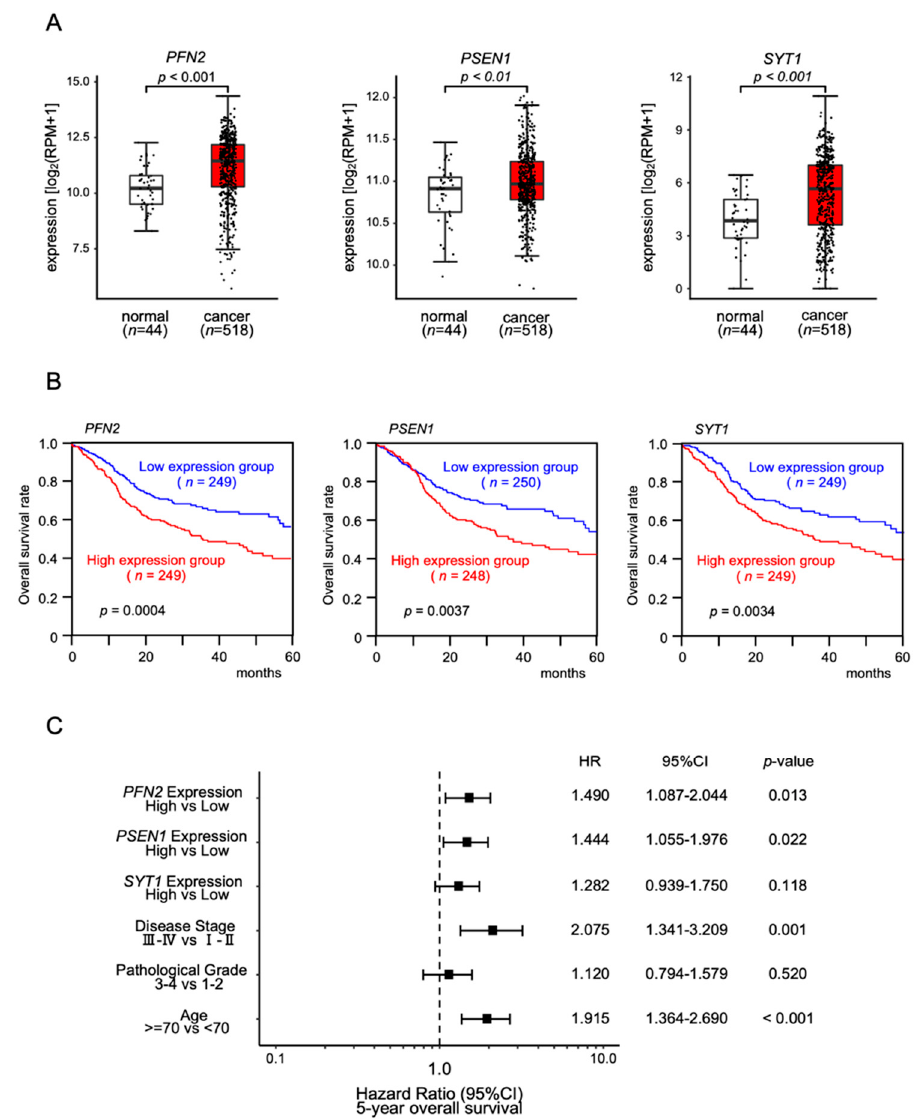
Figure 4. Clinical significance of PFN2 , PSEN1, and SYT1 in HNSCC clinical specimens determined by TCGA–HNSC analysis: ( A ) comparisons of expression levels of three genes between normal and cancer tissues in TCGA–HNSC; ( B ) Kaplan–Meier curves of the 5 year overall survival frequencies according to the expression of each gene; ( C ) forest plot showing the multivariate analysis results for the three target genes (i.e., PFN2 , PSEN1, and SYT1 ) identified by the analysis of the TCGA–HNSC data (HR: hazard ratio; CI: confidence interval).